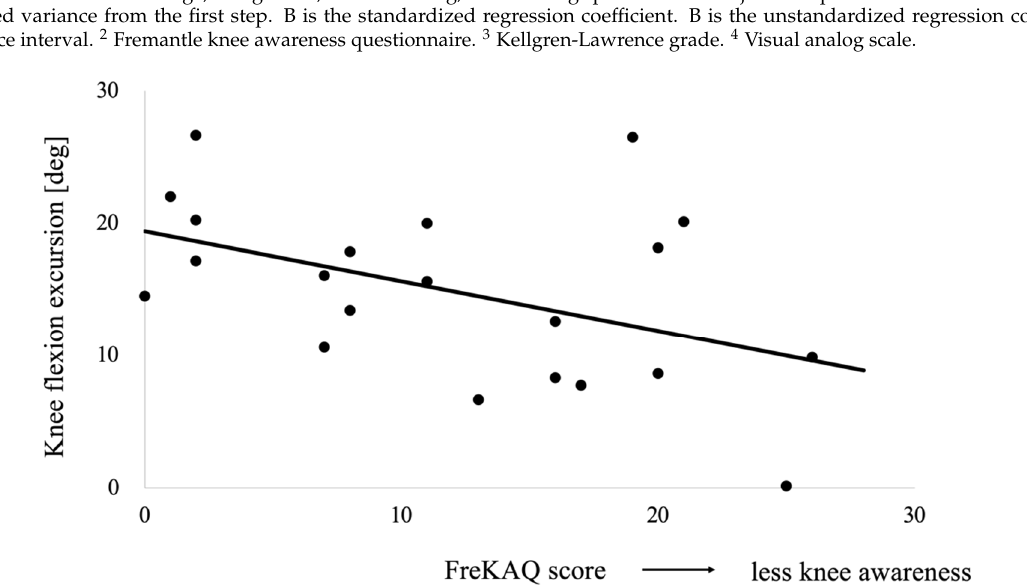
*: p < 0.05. Covariates include age, K-L grade 3 , VAS 4 walking, and walking speed. R 2 is unadjusted explained variance. Δ R 2 is change in explained variance from the first step. B is the standardized regression coefficient. Β is the unstandardized